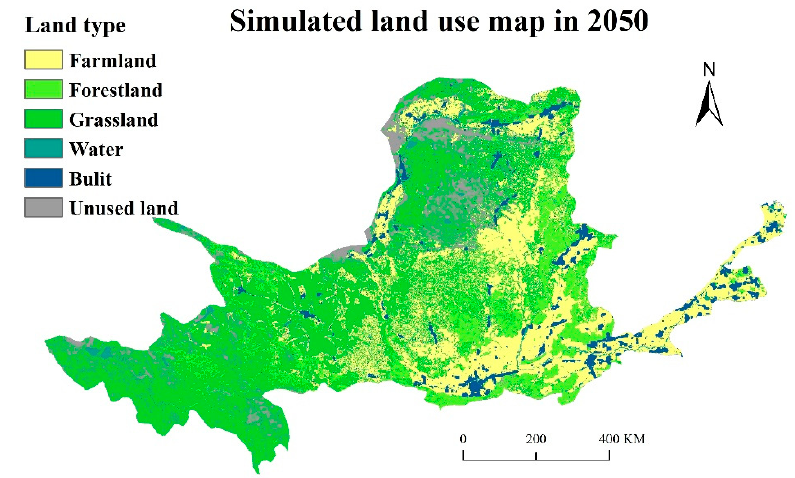
Figure 11. Simulated land use maps of the Yellow River Basin in 2050.